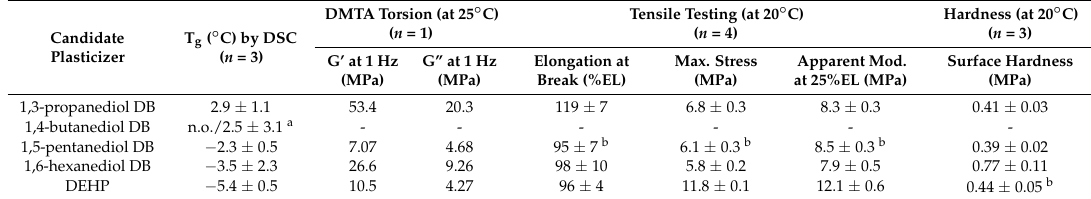
Table 2. Glass transition temperature (T g ), storage moduli (G’), and loss moduli (G”), as determined by dynamic mechanical thermal analysis (DMTA) in torsion mode, elongation at break, maximum observed stress, and apparent modulus at 25% EL, as determined by tensile testing, as well as surface hardness as determined by nano-indentation of 40 phr blends of PVC with the candidate plasticizers.